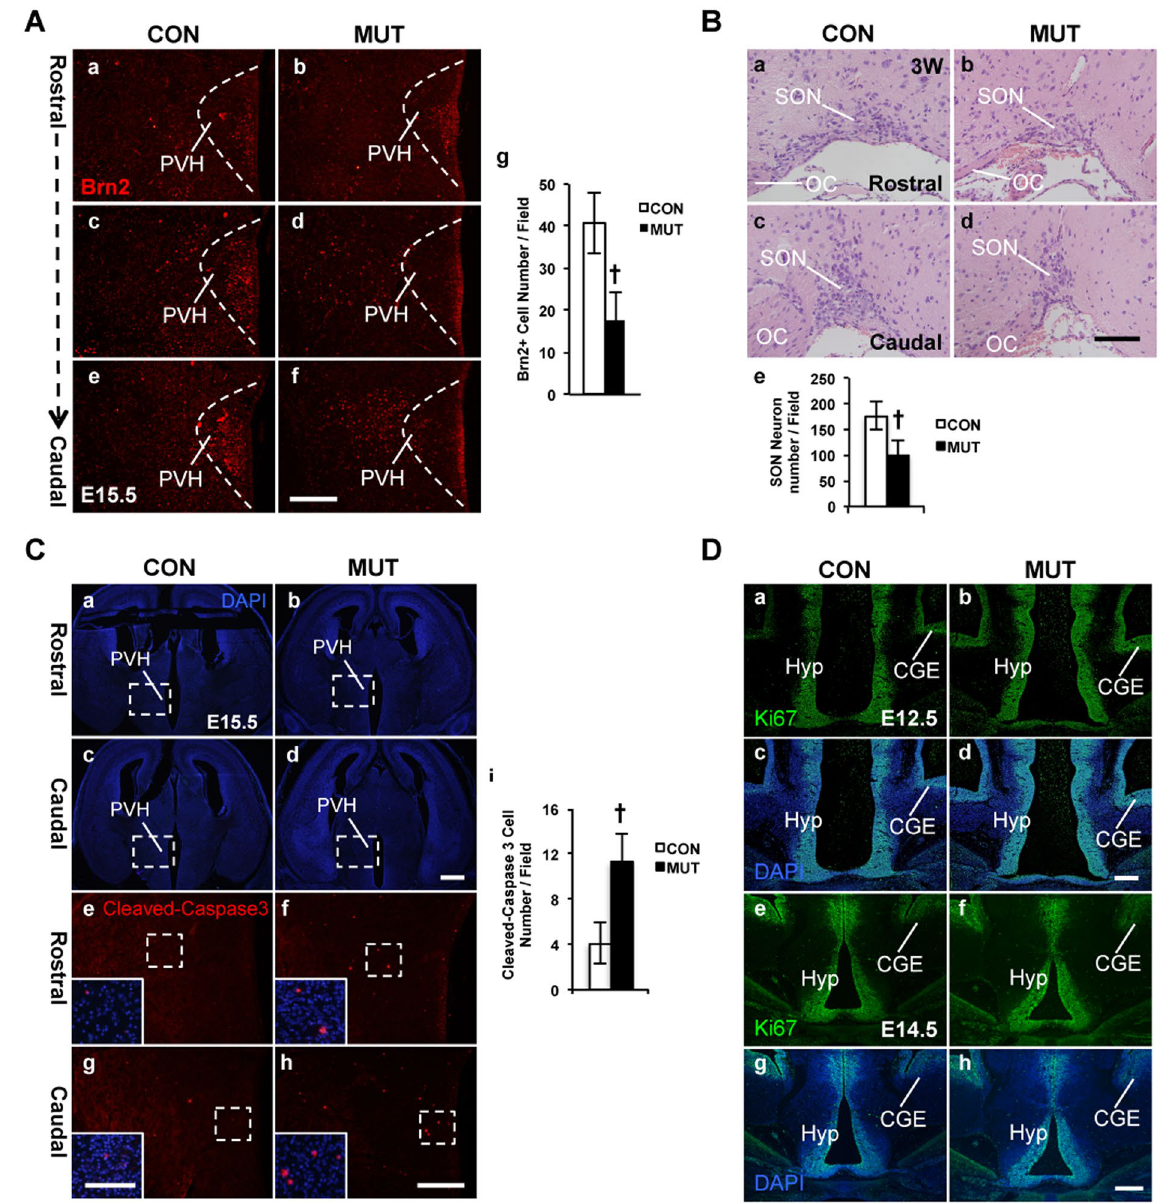
Figure 5. Reduction of the Brn2 + early differentiating PVH neurons, hypocellular SON nucleus, and increased apoptosis in the COUP - TFII mutant. ( A ) Brn2 + early differentiating PVH neurons are reduced in the mutant embryo. Compared with the control ( A a–c), there are much fewer Brn2 + early differentiating PVH neurons along the rostro-caudal axis in the mutant at E15.5 ( A d–f), and the reduction is significant ( A g). The data are collected from three pairs of control and mutant embryos. ( B ) Development of the SON nucleus is abnormal in the adult mutant mouse. The H&E staining data show that compared with the control ( B a,b), there are much fewer SON neurons in the COUP - TFII mutant ( B c,d). The reduction of magnocellular SON neurons is significant in the mutant ( B e). ( C a–h) Increased apoptosis is detected in the COUP - TFII mutant embryo. DAPI staining images of coronal sections with PVH region in the control ( C a,c) and the mutant ( C b,d) at E15.5. Compared with the control ( C e,g and inserts), there are more cleaved-Caspase-3 signals in the mutant PVH region at E15.5 ( C f,h and inserts), and the increase of the cleaved-Caspase-3 signals is significant ( C i). ( D a–h) Proliferation is not affected in the COUP - TFII mutant. The expression of Ki67 is comparable between the control ( D a,c) and mutant ( D b,d) at E12.5. Expression of Ki67 is comparable between the control ( D e,g) and mutant ( D f,h) at E14.5. CGE, caudal ganglionic eminence; OC, optic chiasm; PVH, paraventricular nucleus of hypothalamus; SON, supraoptic nucleus. At least three pairs of the control and the mutant mice were used in each study. The data indicate the mean ± SD. Student’s t-test, † P < 0.001. Scale bars, ( A a–f) 200 μ m; ( B a–d) 100 μ m; ( C a–d) 500 μ m; ( C e–h, D a–h) 100 μ m; inserts of ( C e–h) 50 μ